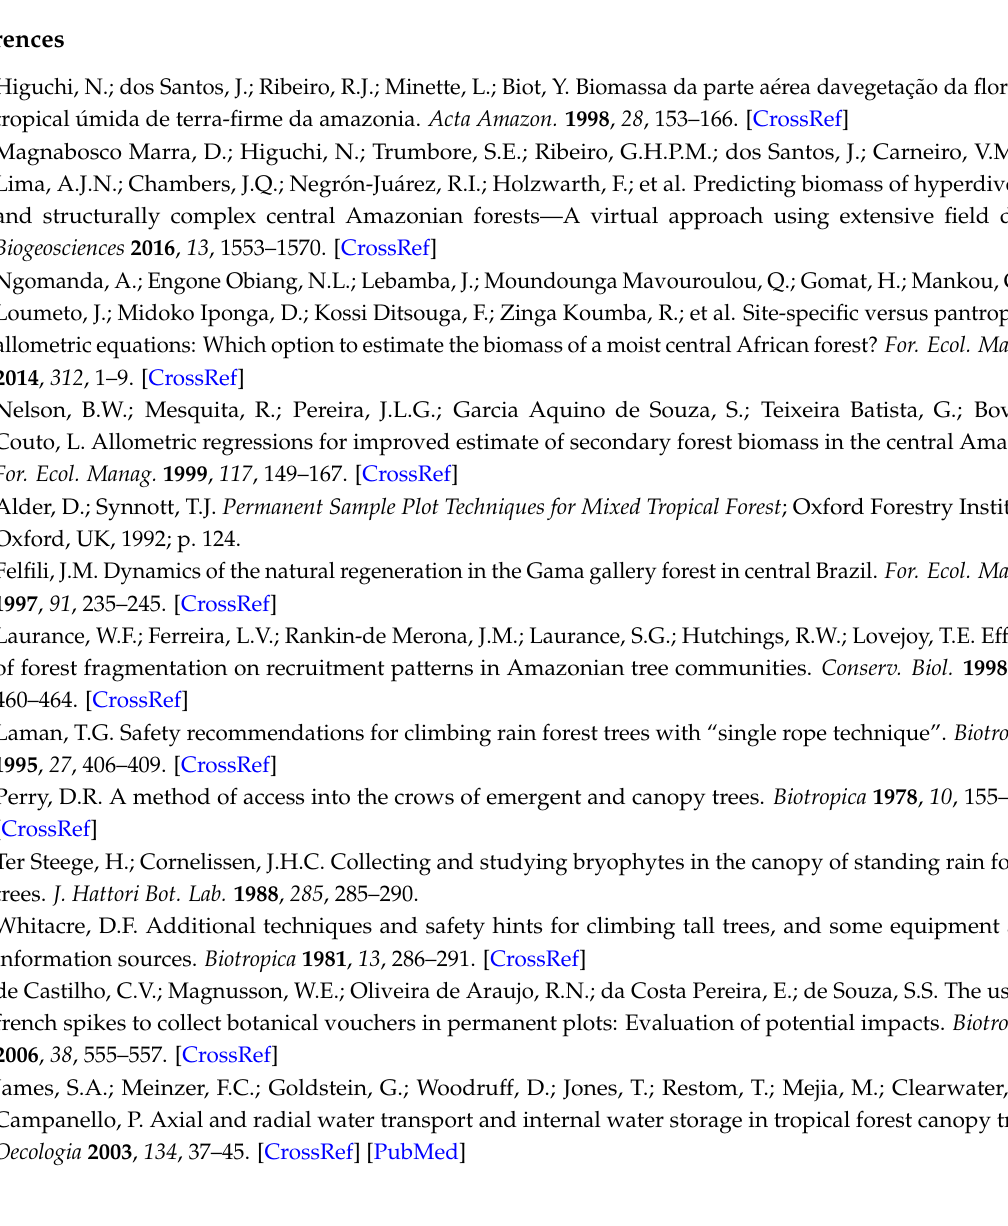
Table S1: Measured sample trees, Table S2: Dendrometric